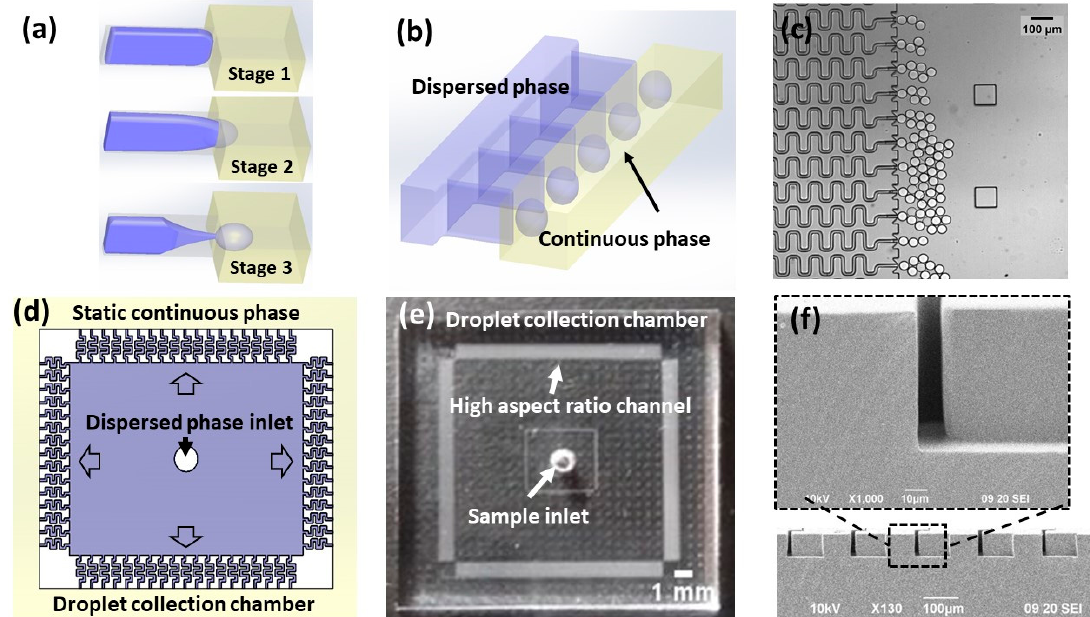
Figure 1. Schematic diagram and photographs of the high-aspect-ratio-induced self-breakup (HIDS) device: ( a ) Schematic showing the droplet breakup process by Plateau–Rayleigh instability in a single HIDS structure where the dispersed phase (purple) is confined in an energy-unfavorable shape. When the channel opens wide at the end, the confined shape is released and the interfacial tension drives the dispersed fluid through elongation, thread thinning, and breakup into droplets in the continuous phase (yellow). ( b ) Schematic showing the parallel integration of an array of the HIDS generators. ( c ) A micrograph of parallelized HIDS generators and generated monodispersed droplets. ( d ) A layout of a parallelized generator device indicating the sample applied at the center and emulsified into the continuous phase through the HIDS generators and collected in the droplet collection chamber in peripheral. ( e ) A photograph of the device with a simple sample inlet and HIDS generators indicated by arrows. ( f ) A SEM image showing the cross-section of the channels with a width of 13 µ m and height of 65 µ m.